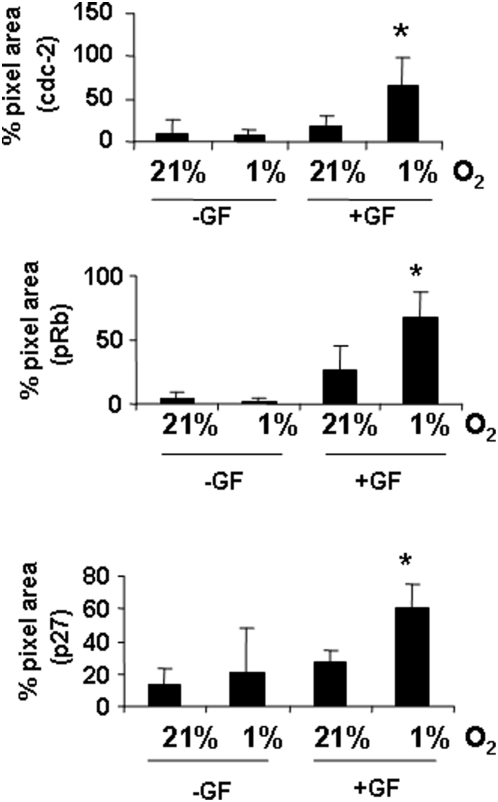
Changes in OL cell cycle proteins in 1% O2.Densitometric analysis of data in Figure 9 was done by normalizing protein levels to ribosomal S6 protein levels. The percent increase in the expression of cell cycle proteins is shown relative to levels in 21% O2 (* p<0.05, ** p<0.01). Data shown are representative of three separate studies.